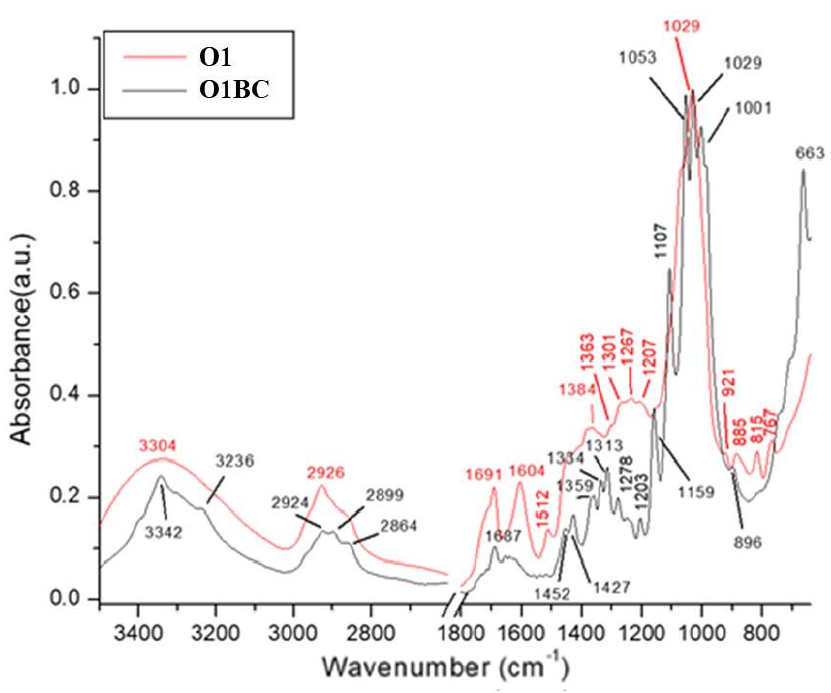
Figure 8. FT-IR spectra of oregano extract (O1) and bacterial cellulose incorporated with oregano extract (O1BC).